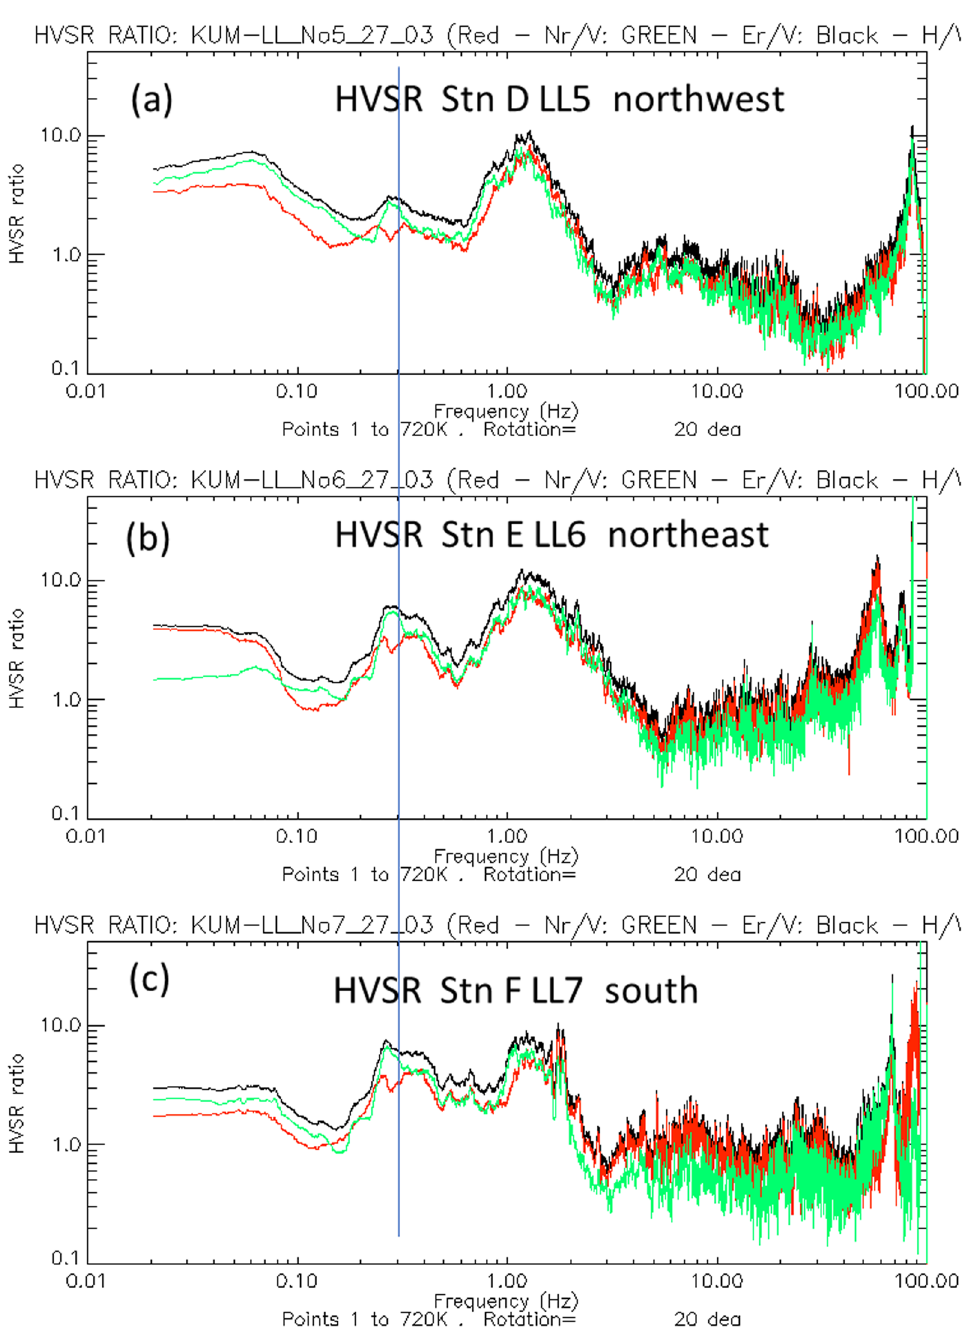
Fig. 3 HVSR spectra for array LL vertices, showing (black) H/V, (red) Nr/V and (green) Er/V, where Nr and Er are orthogonal components of N and E horizontal signal rotated by 20 degrees from north. The vertical blue line shows that the 0.3 Hz HVSR peak for station LL5 is clearly